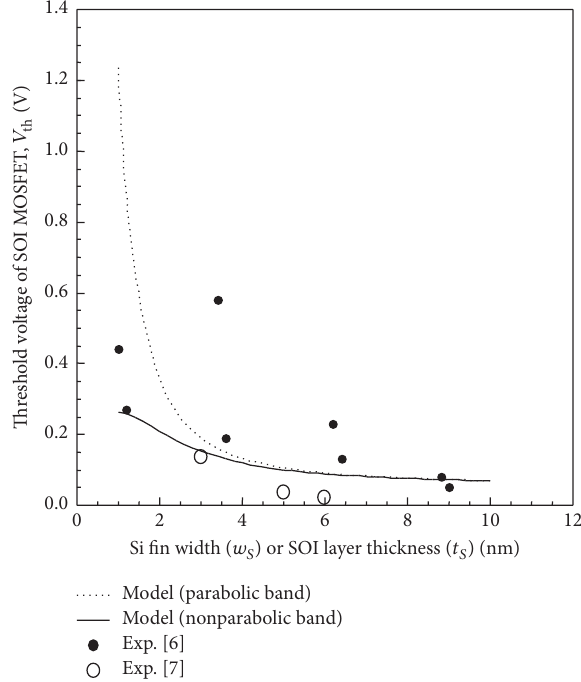
[7]Model (parabolic band) Model (nonparabolic band) Exp. Exp. Figure 3: 𝑉 th dependence on fin width or SOI layer thickness of Si SOI MOSFET device. The devices shown in [6] are two- dimensionally confined with (001) and (011) surfaces. It is assumed that the gate oxide layer is 3 nm thick, the body silicon layer is 7nm thick for [6], and 𝛼 = 0.5 eV −1 . The devices shown in [7] are two- dimensionally confined with (001) surface. It is assumed that the gate oxide layer is 50 nm thick, the body silicon layer is ranging from 3 nm to 6 nm thick for [7], and 𝛼 = 0.5 eV −1 . It is also assumed that 𝑚 ∗ /𝑚 𝑚 ∗ /𝑚 0 = 0.916 for (001) Si surface and 0 = 0.314 for (011) Si